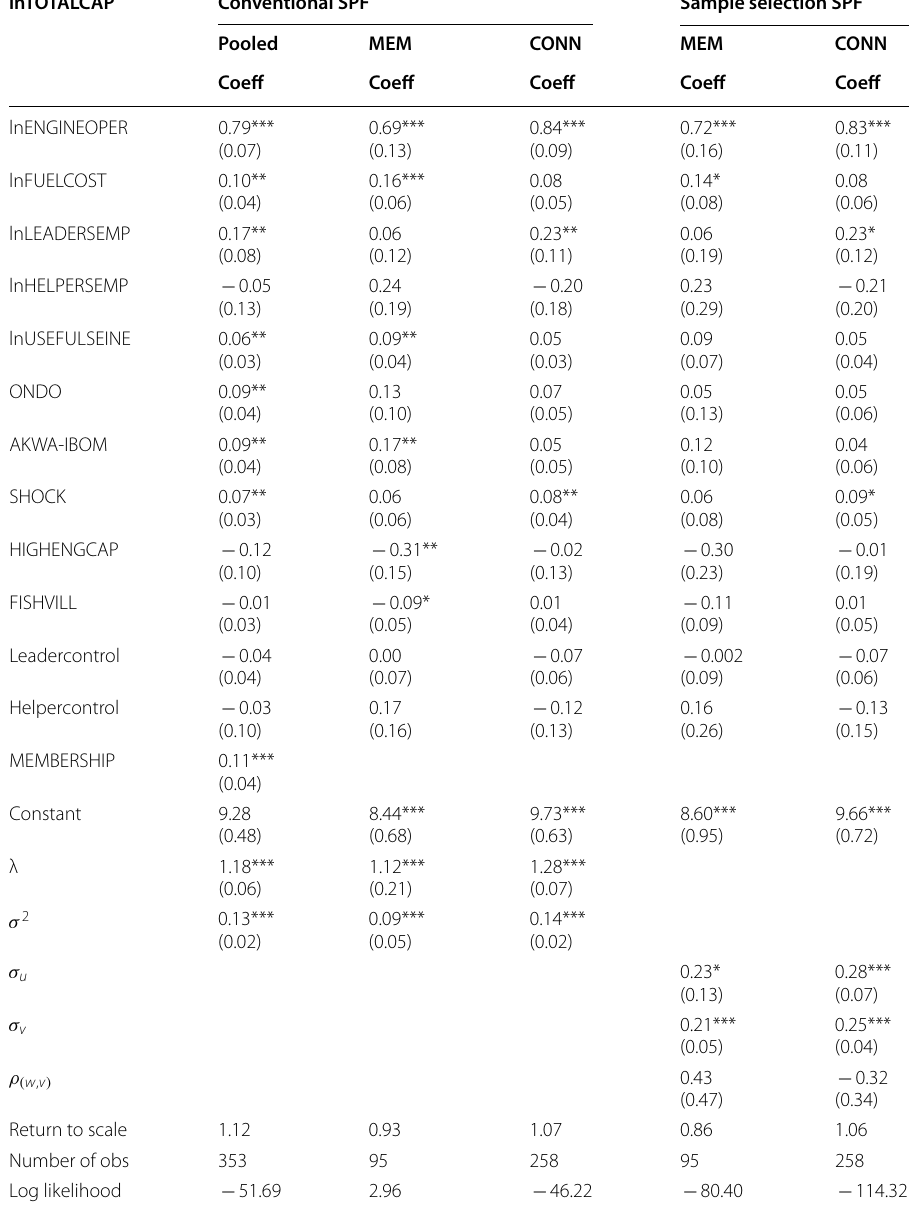
Table 4 Parameter estimates for conventional and selectivity SPF models: Unmatched